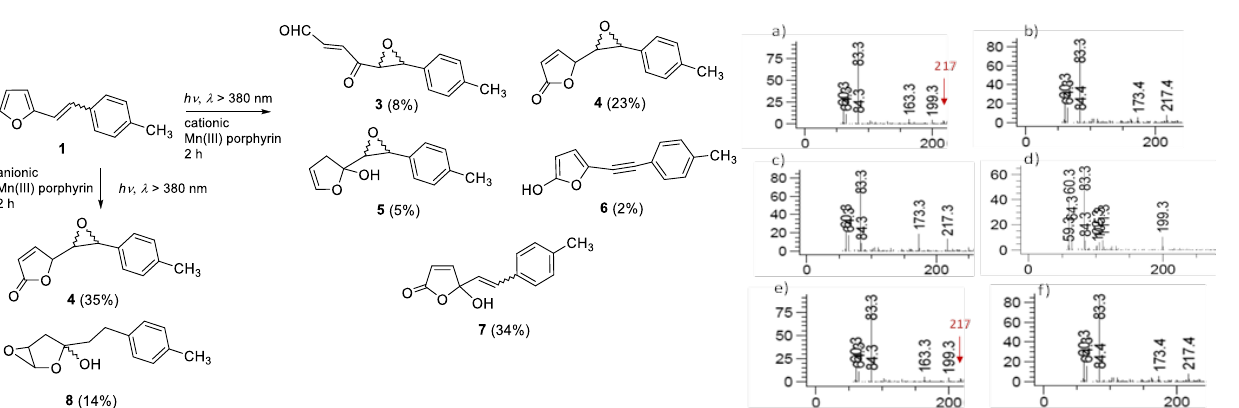
Figure 5. Partial 1 H NMR spectra (CDCl 3 ) of starting compound 1 ( a ), formyl derivative 3 ( b ), unsaturated carbonyl com- pound 7 ( c ), and epoxy structure 4 ( d ) with characteristic patterns for assignation of the products’ structure. Photooxygenated products 4 and 8 show the characteristic aliphatic part of the NMR spectra with three signals with the ratio of integrals of 1:1:1 ( 4 ) or two triplets, which cor- respond to two methylene groups ( 8 ) (Figure 6). In the 1 H NMR spectrum of photoproduct 8 , also the integral of four protons at about 2 ppm can be found beside the signal of the methyl group. All these pieces of information together with the masses of six products ( 3 – 8) , confirmed by UPLC/MS analysis, clearly show the tendency of the starting furostilbene 1 under the conditions of photooxygenation using Mn(III) porphyrins and the reactivity of the furan ring. In addition to these isolated products, several additional products were detected in traces in the enriched fractions, with characteristic signals in the proton NMR indicating the existence of some formyl or epoxy derivatives. PPM 9.6 ad